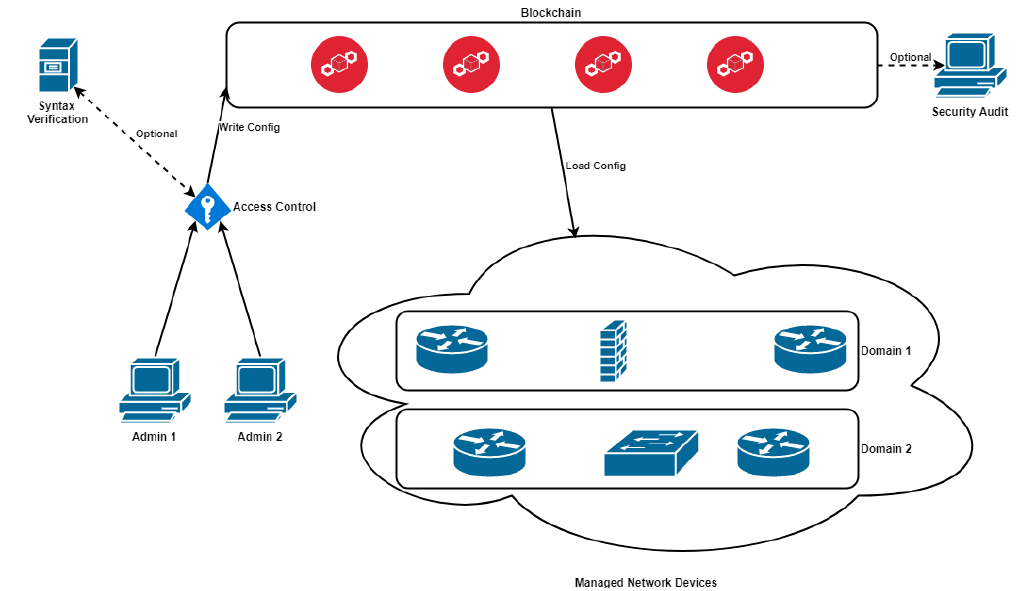
Figure 1. Proposed architecture for network monitoring and management over blockchain.